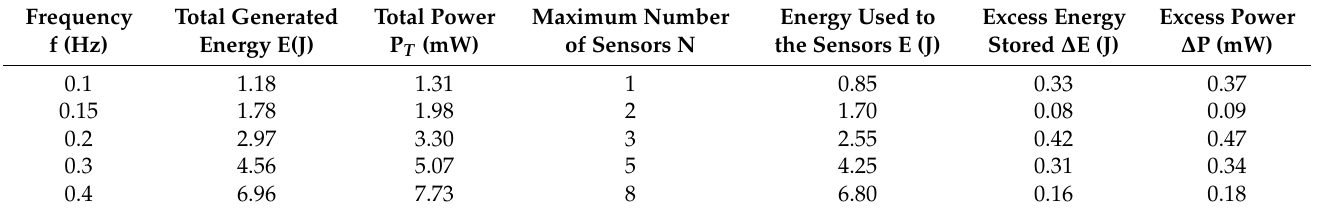
Table 6. Number of sensors powered for each movement frequency. The energy was calculated for 900